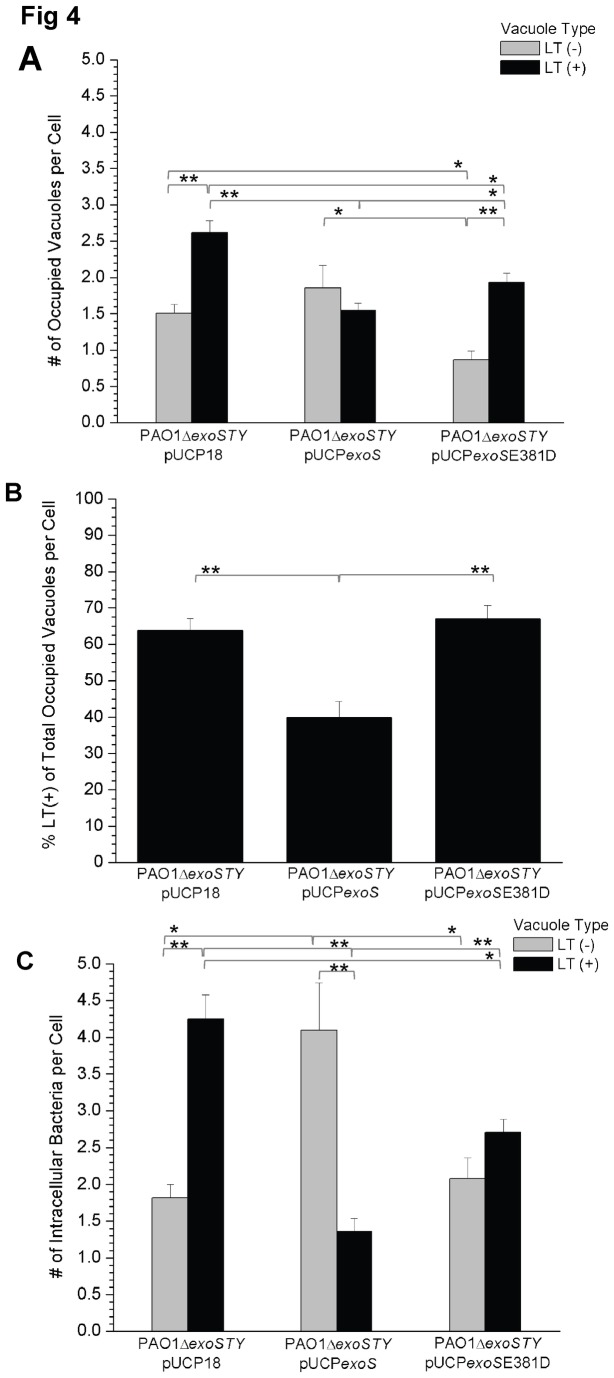
Quantification of acidified versus non-acidified vacuole occupation by a triple effector type III secretion mutant of P. aeruginosa complemented with either exoS or exoS without ADPr activity.(A) Confocal microscopy images were used to classify bacteria-occupied vacuoles as LysoTracker LT (+) (acidified) or LT (-) at 5 h post-infection with a triple effector mutant of P. aeruginosa (PAO1ΔexoSTY) complemented with exoS (pUCPexoS), exoS without ADPr activity (pUCPexoSE381D) or a vector control (pUCP18). Data are shown as the mean (+/- SEM) values of bacteria-occupied vacuoles per cell. Grey columns denote LT (-) vacuoles, black columns denote LT (+) vacuoles. Calculations excluded cells showing bleb-niche formation. Without ExoS ADPr activity (complementation with pUCP18 or pUCPexoSE381D), there were significantly more acidified bacteria-occupied vacuoles per cell (p < 0.05 Welch’s corrected t-Test). (B) The number of LT (+) bacteria-occupied vacuoles per cell was also calculated as a function of the total number of bacteria-occupied vacuoles per cell. Mean percentage (+/- SEM) is shown. Expression of ADPr active exoS was associated with reduced occupation of acidified vacuoles. Calculations also excluded cells showing bleb-niche formation. (C) Mean (+/- SEM) values of intracellular bacteria were determined to account for both the number of bacteria per vacuole and bacteria within blebbing cells in non-vacuolar niches. Complementation of the triple effector mutant PAO1ΔexoSTY with exoS (pUCPexoS) significantly reduced the number of intracellular bacteria per cell within acidified compartments. Grey columns denote LT (-) vacuoles, black columns LT (+) vacuoles. Each panel above is a representative experiment of 3 independent experiments. Significant differences were observed between groups by ANOVA (p < 0.0001). Welch’s corrected t-Test was used in pair-wise comparisons [*p < 0.05, **p < 0.001].